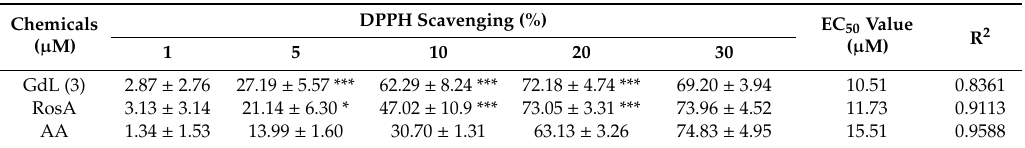
Figure 4. 2,2-Diphenyl-1-picrylhydrazyl (DPPH) radical scavenging activity of ascorbic acid (AA), rosmarinic acid (RosA), and GdL (3).